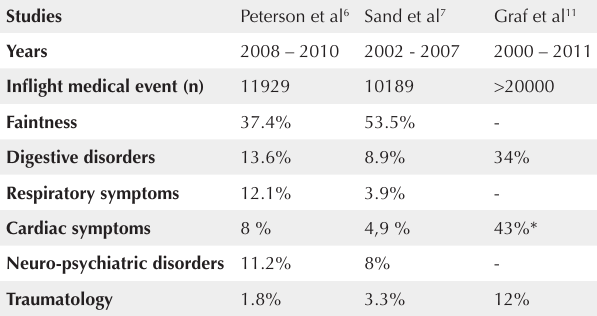
Table 1. Types of Inflight Medical Events